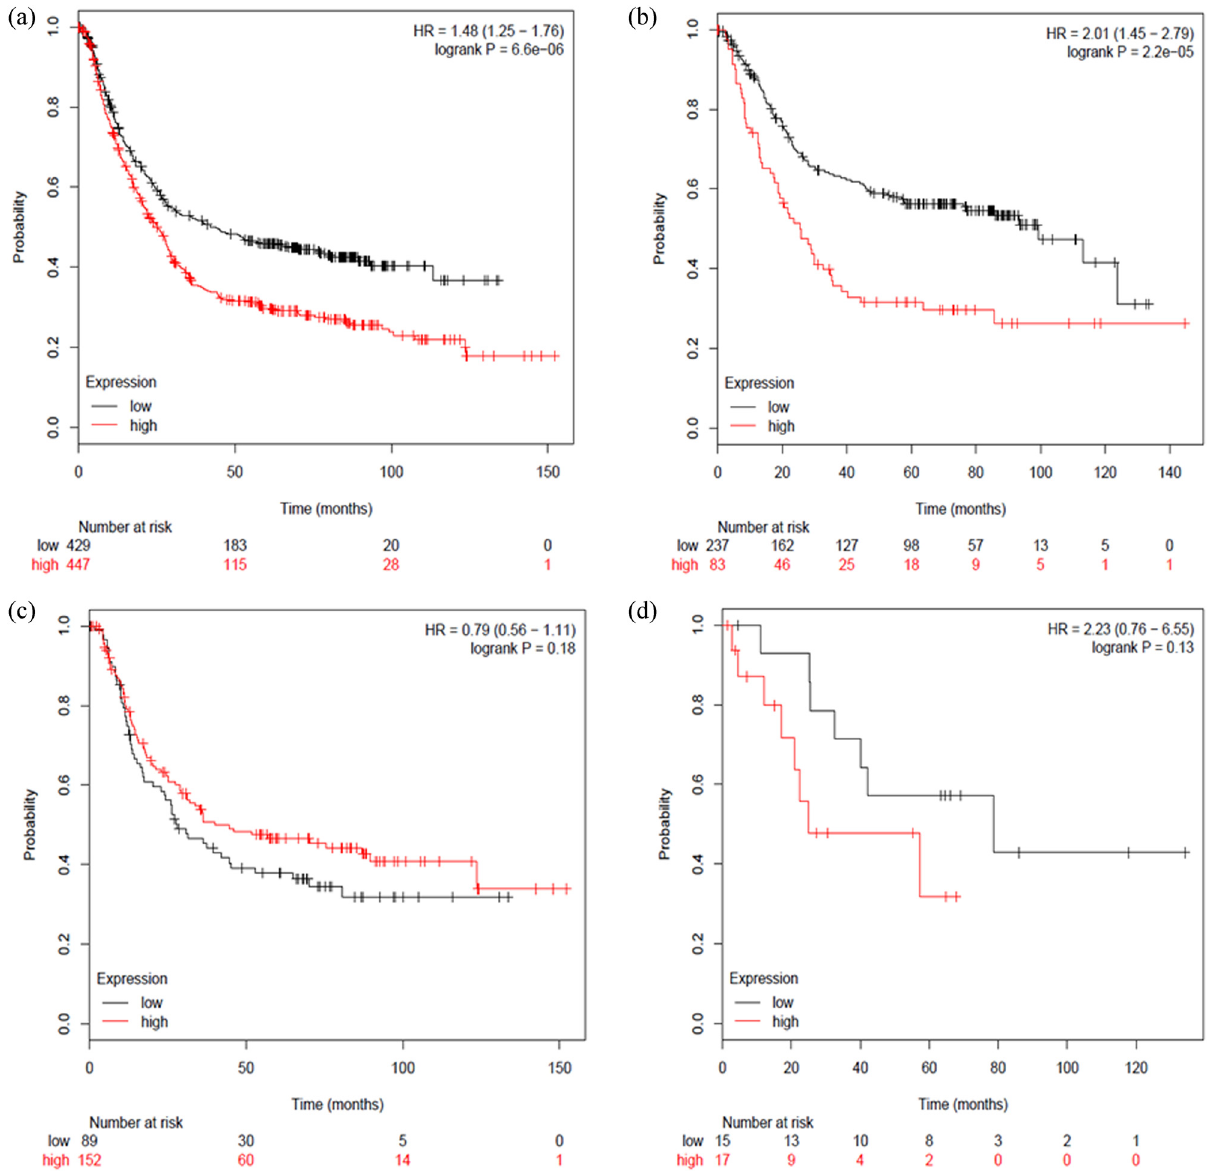
Figure 4: Determination of the prognostic value of ROR γ mRNA expression using www.kmplot.com. The desired A ff ymetrix ID is valid: 206419_at ( ROR γ ) . ( a ) Survival curves were plotted for all patients with GC ( n = 876 ) . ( b ) Survival curves were plotted for patients with intestinal - type GC ( n = 320 ) . ( c ) Survival curves were plotted for patients with GC ( n = 241 ) . ( d ) Survival curves were plotted for patients with mixed - type GC ( n = 33 )